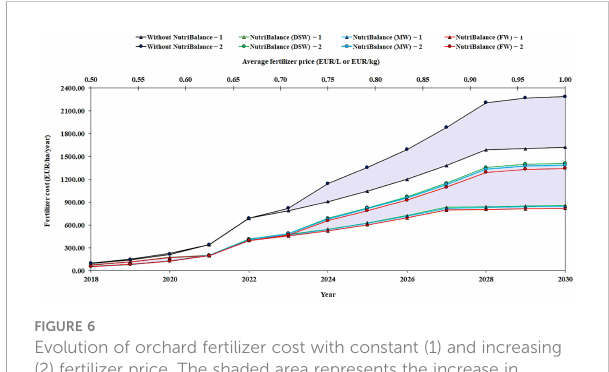
FIGURE 6 Evolution of orchard fertilizer cost with constant (1) and increasing (2) fertilizer price. The shaded area represents the increase in fertilizer cost due to the rising price